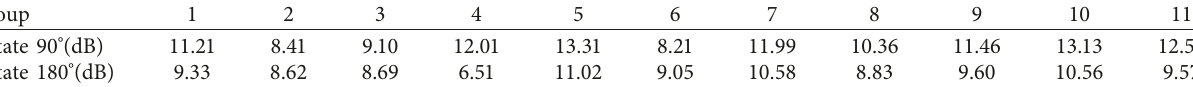
Table 4: The realized gains with the phases of rotating elements changing separately 90 ° and 180 ° .